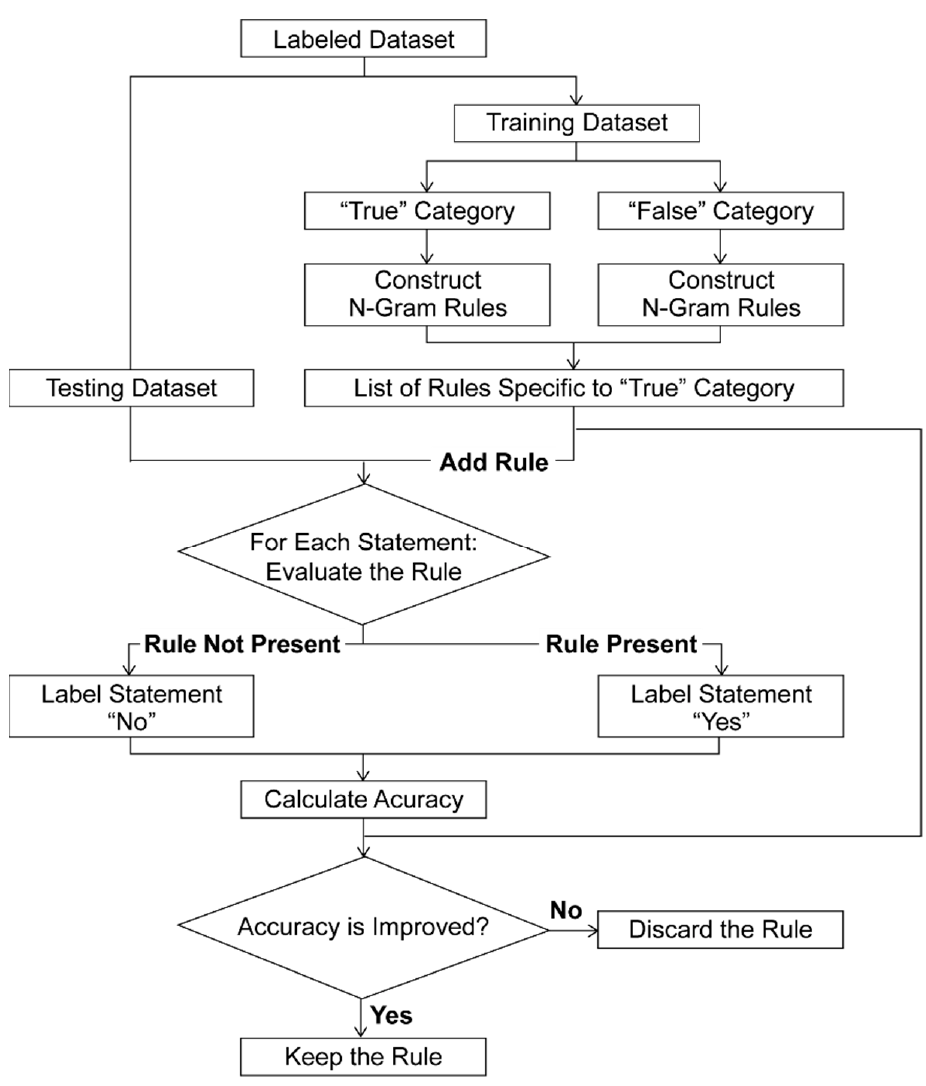
Figure 4. Rule-based classification.